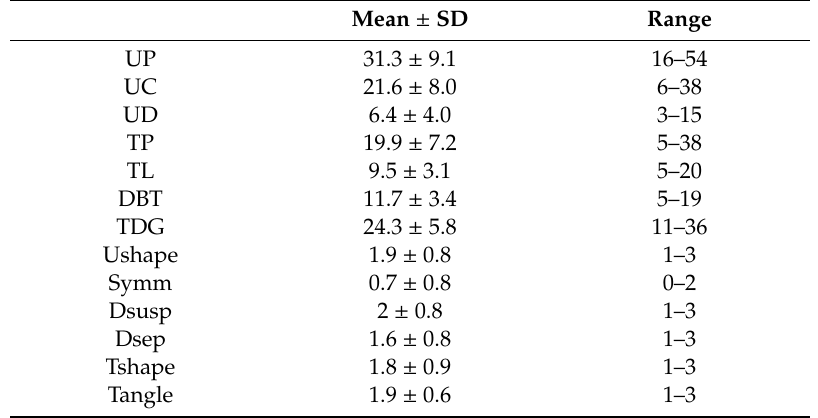
Table 1. Descriptive statistics of the udder’s evaluated morphological parameter ( n = 60).